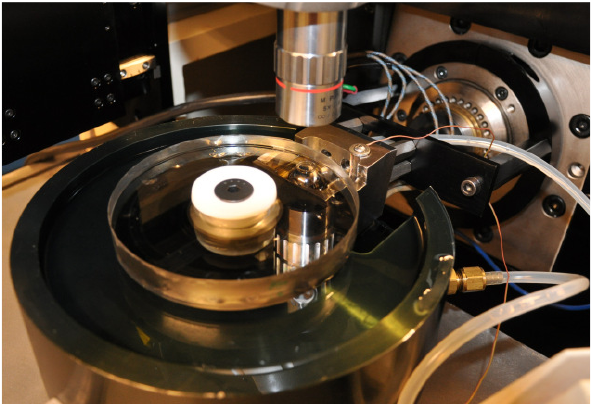
Figure 2. Wedeven Associates Machines ball on disc test apparatus with optical interferometry